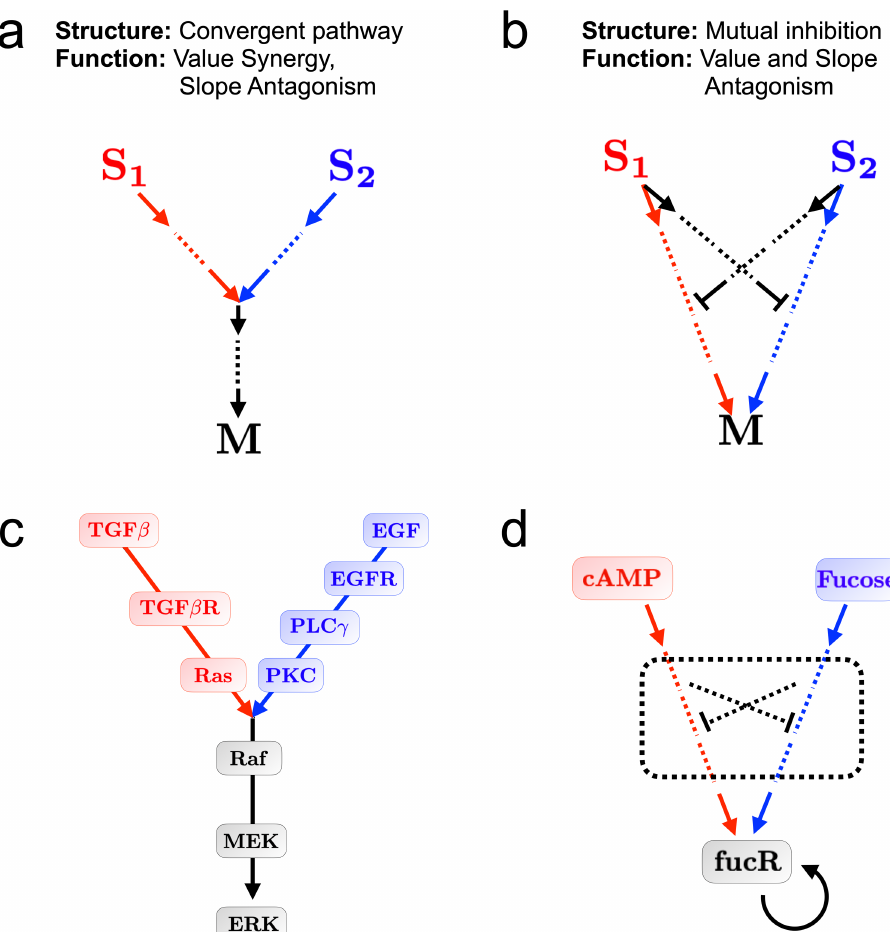
Fig. 6 Common structural features. a The minimal networks that exhibit slope antagonism (Fig. 4b, d, and f, top) also exhibit value synergy and have a common structure of two converging pathways. b The minimal networks that exhibit value antagonism (Fig. 5b, d, and f, top) also exhibit slope antagonism and have a common structure of two mutually inhibitory pathways. c The network that integrates EGF and TGF- β in cancer cells shows pathway convergence, consistent with migration experiments on cancer cell lines indicating value synergy and slope antagonism 24 . Network adapted from ref. 30 . d The fucR gene exhibits value antagonism in response to fucose and cAMP 38 . Our analysis predicts that mutually inhibitory interactions should exist in the network downstream of fucose and cAMP and upstream of